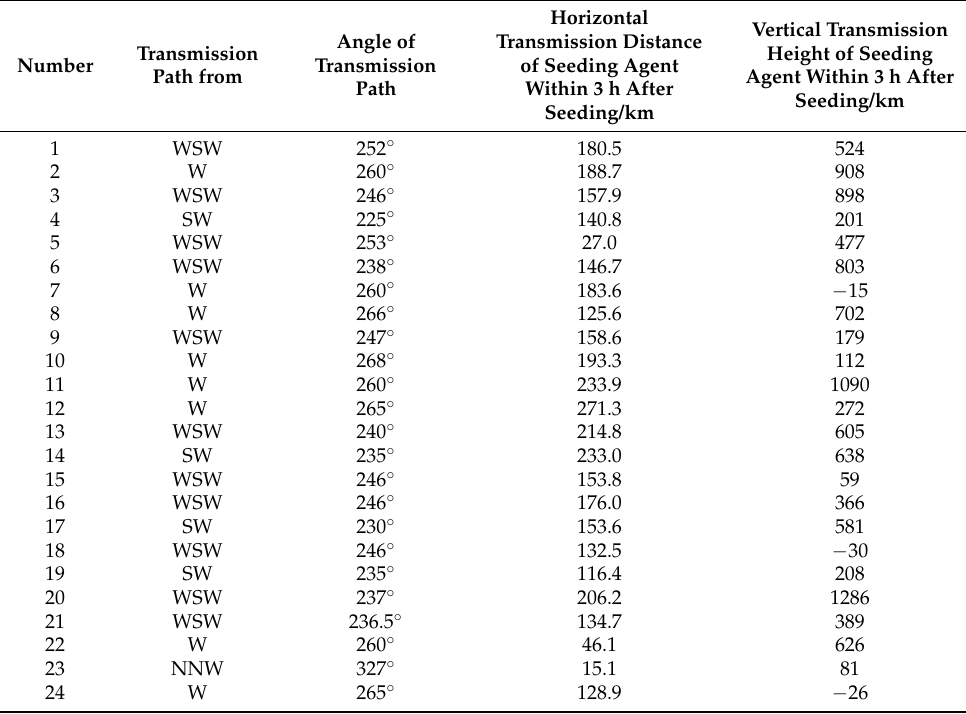
Table 3. Statistics of features of seeding agent transmission within 3 h after 24 aircraft precipitance enhancement